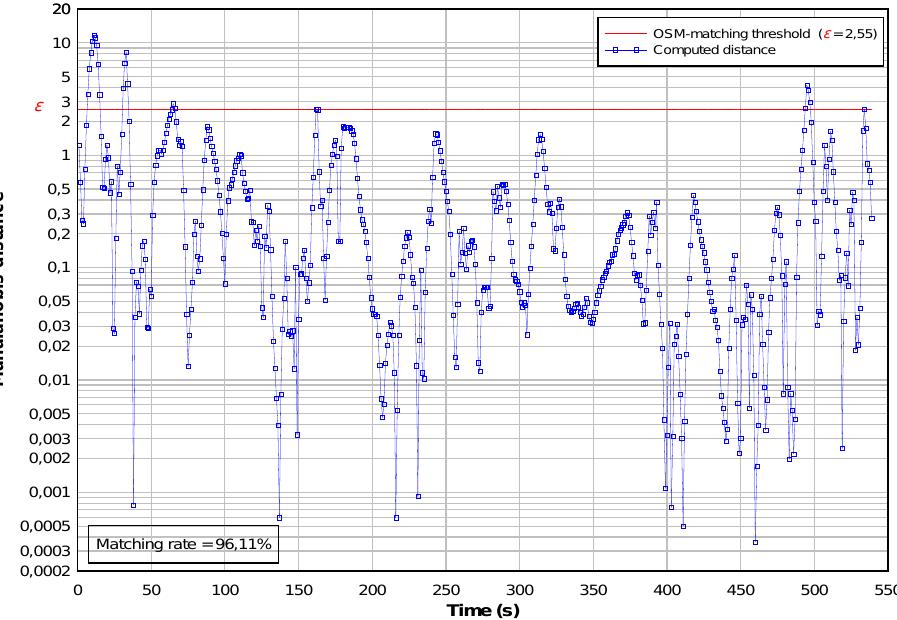
Figure 6. Time-evolution of the OSM-based matching